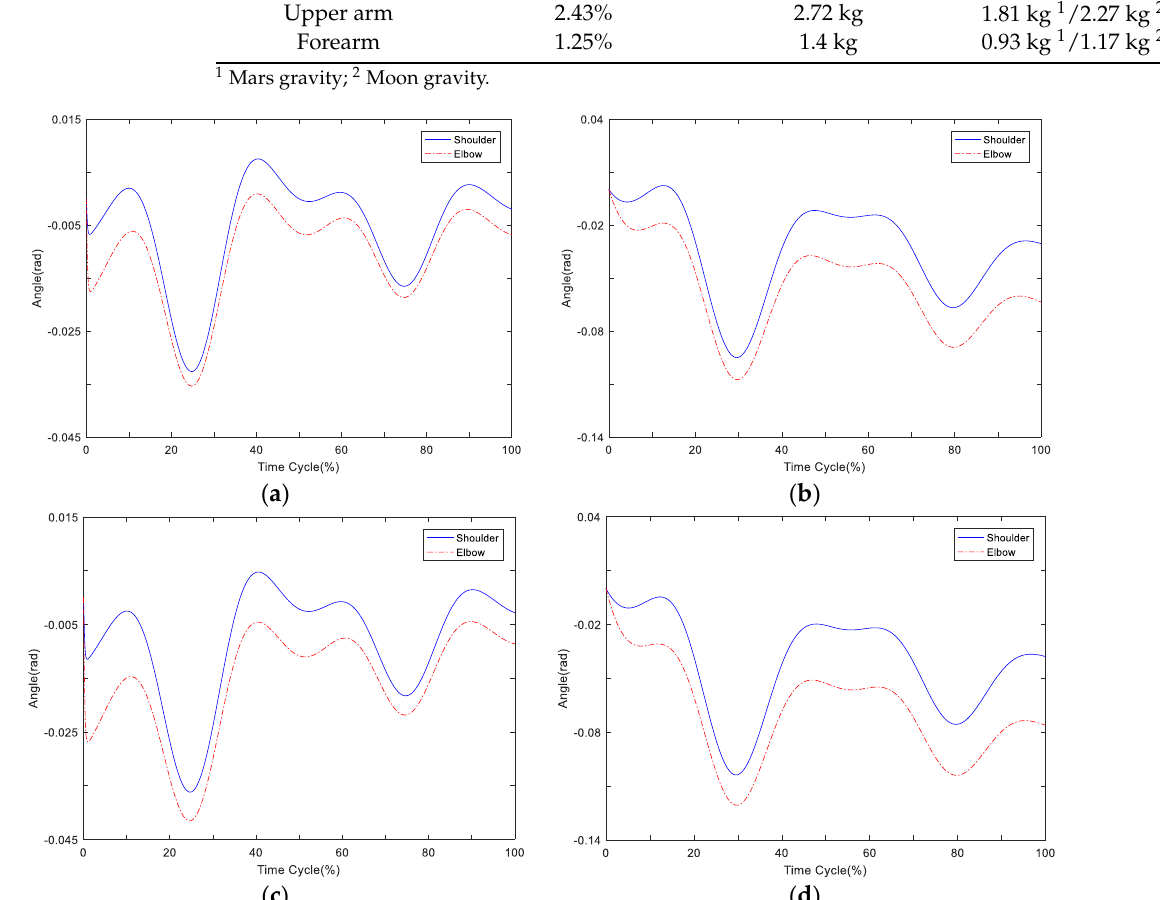
Figure 11. The tracking errors for upper limb joints: ( a ) adaptive neural network control with fuzzy compensation in Mars gravity; ( b ) RBFNN control based on computational torque method in Mars gravity; ( c ) adaptive neural network control with fuzzy compensation in Moon gravity; ( d ) RBFNN control based on computational torque method in Moon gravity. Table 3. The maximum tracking errors in the three gravitational environments.